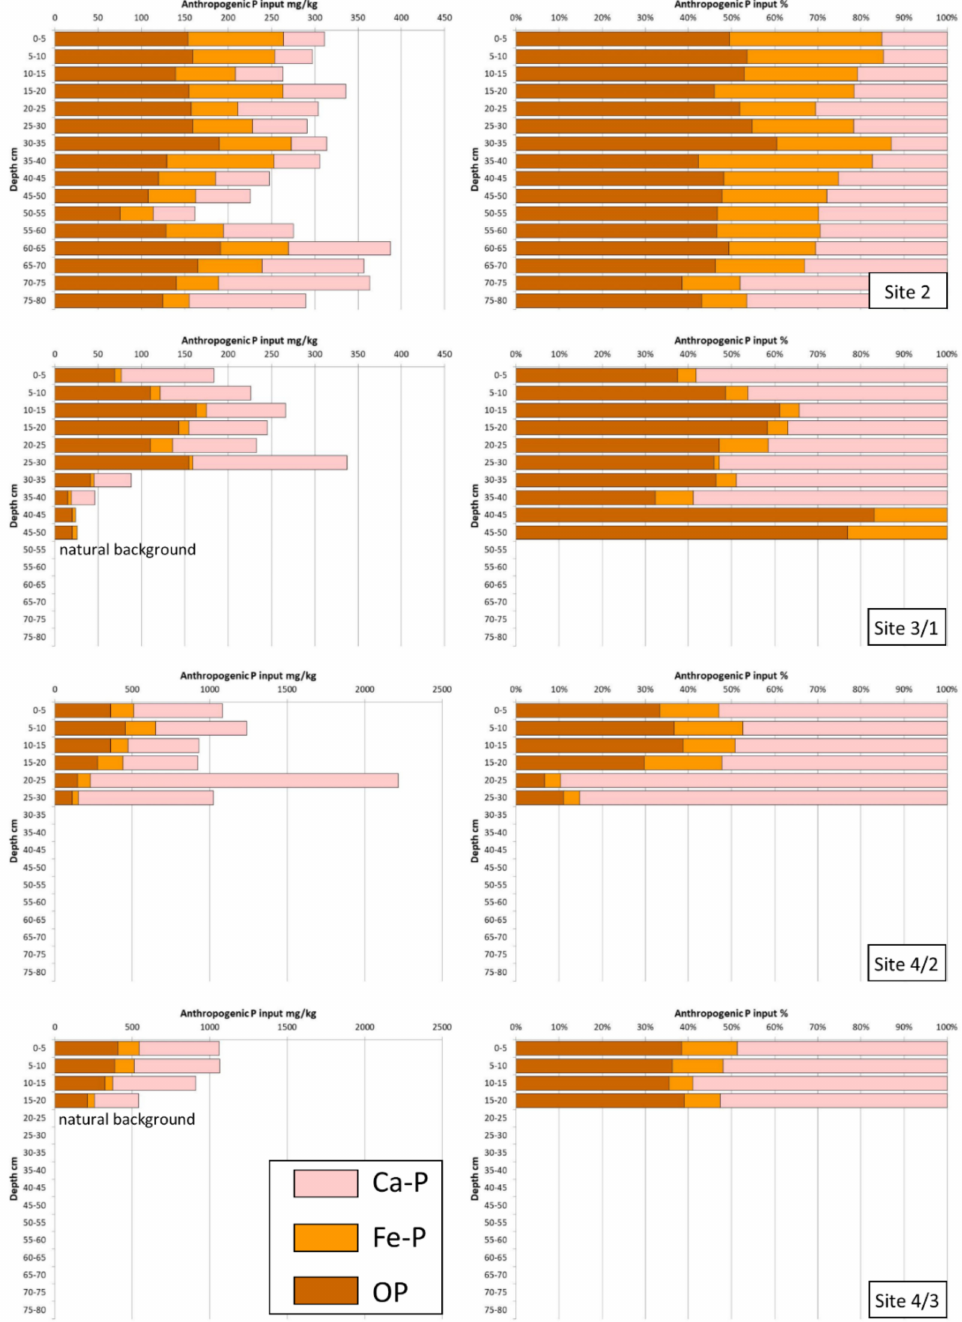
Figure 6. TP SMT and P forms of the anthropogenic input in core samples, calculated by assuming that the bottom layer of core 3 / 1 represents the natural background concentration for cores 2 and 3 / 1, and core 4 / 3 bottom layer represents the natural background concentration for cores 4 / 2 and 4 /